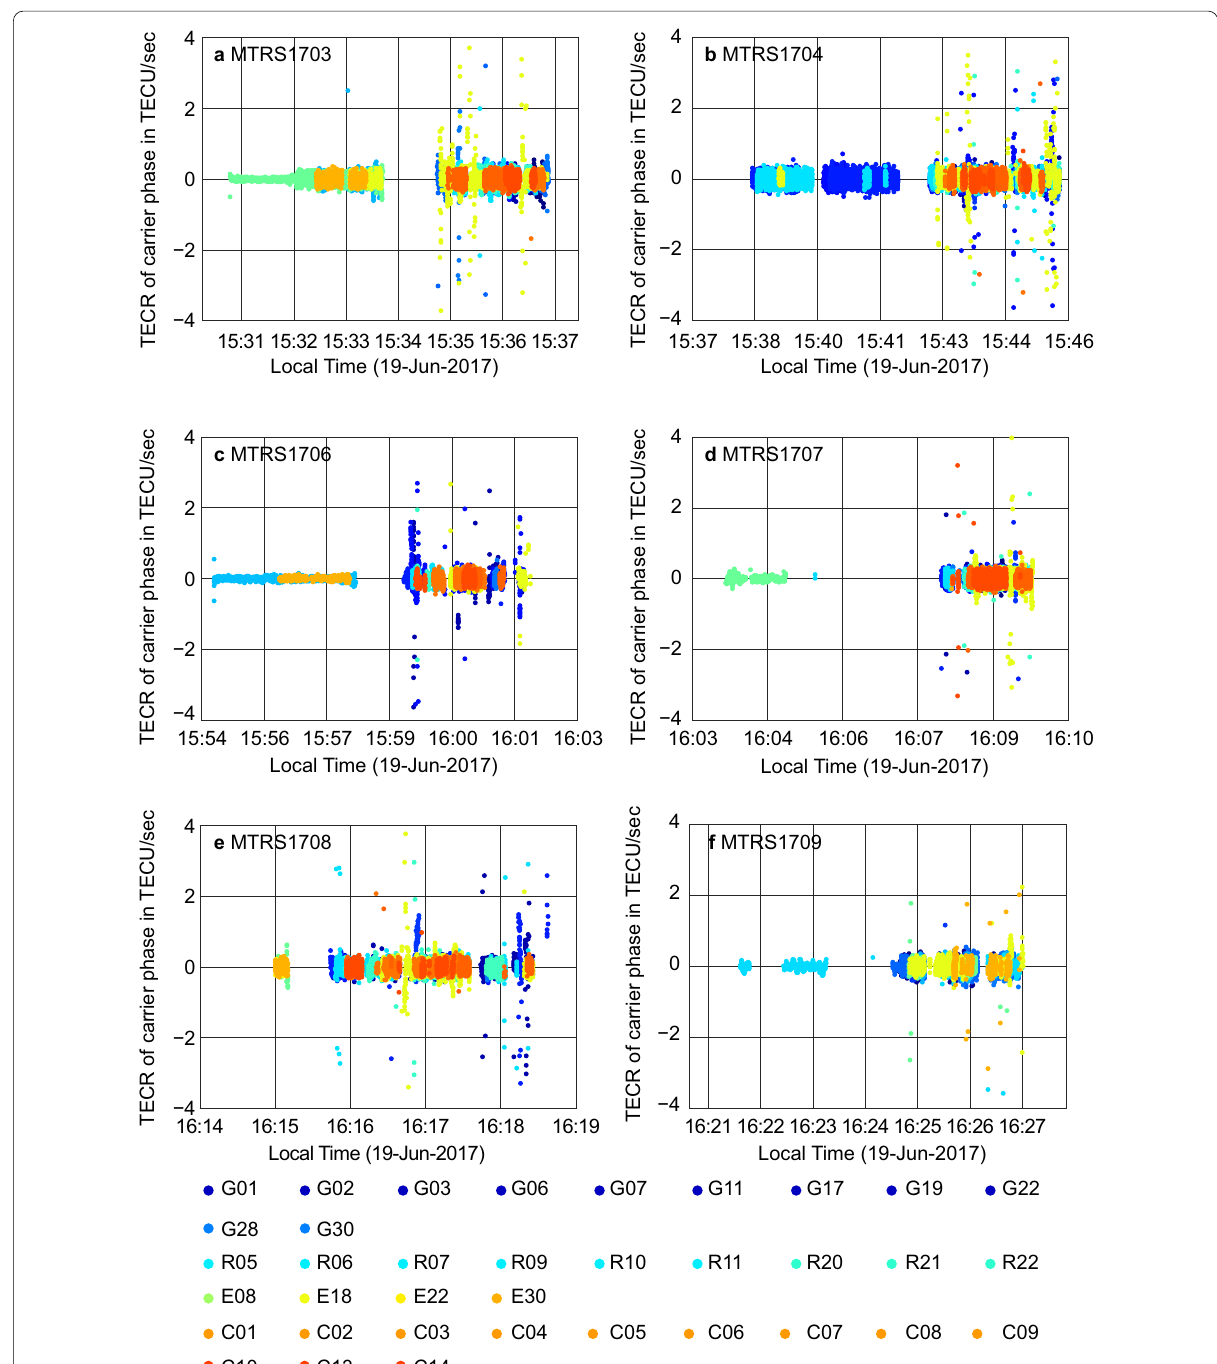
Fig. 7 TECR derived from six test datasets on carrier phase measurements. They were collected on the moving MTR train and showed in ( a – f ). The MTRS170x implies that TECR was observed on the MTR train and were derived from the x-th session on the 170th day of